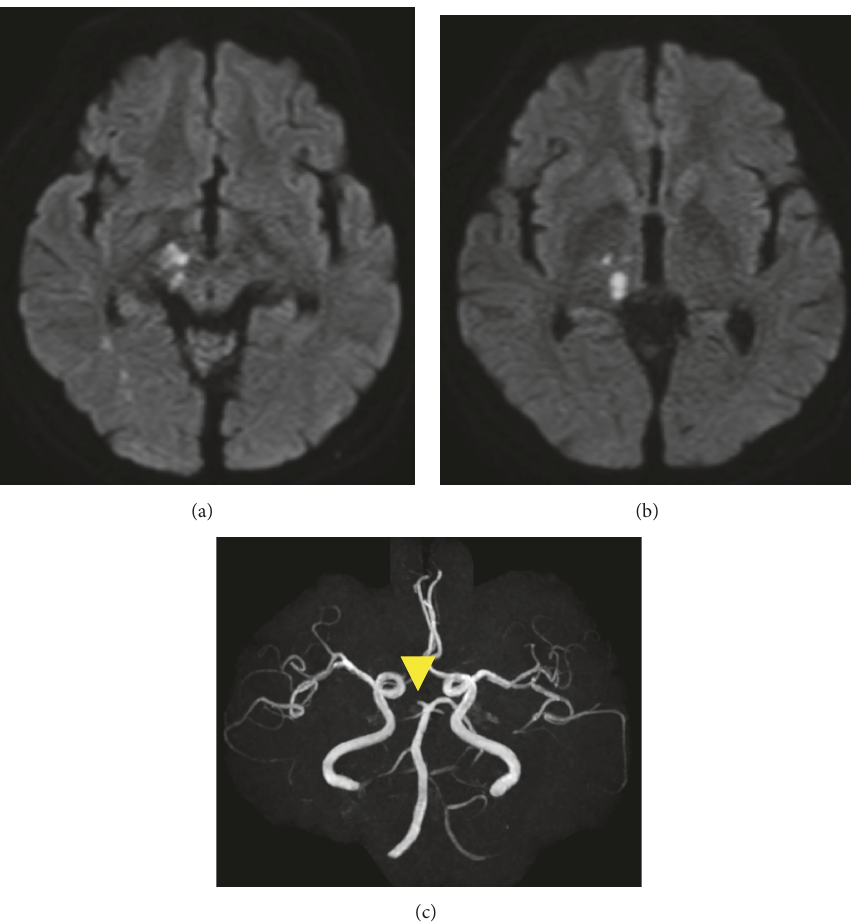
Figure 1: Head MRI performed about 24 hours after onset showed right occipital lobe, thalamus, cerebral crus, and midbrain fresh infarction (a, b). MRA showed right P2 (arrow head) and left SCA (superior cerebellar artery) occlusion